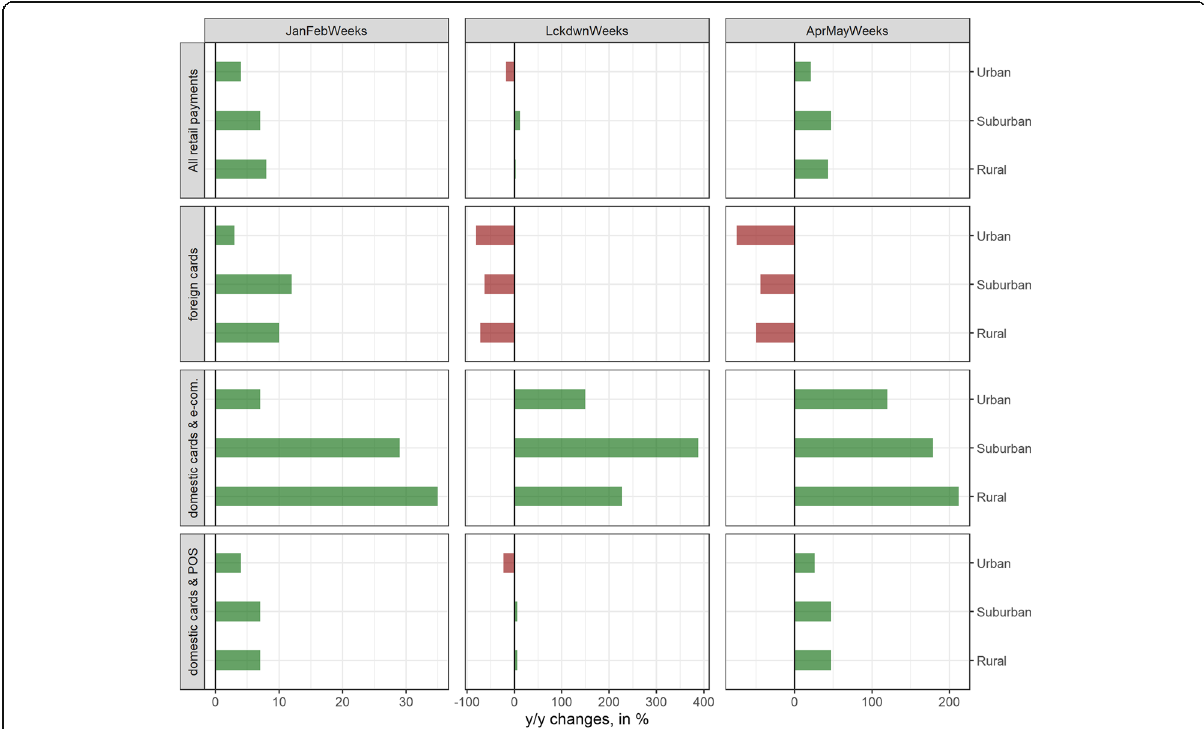
Fig. 8 Excess retail card payments (percentages) differentiated according to all payments (first panel), foreign-issued card payments (second panel), domestic card-not-present payments (third panel), and domestic card-present payments (fourth panel), and differentiated by urban, suburban, and rural areas (sub-panels) for the pre-lockdown (left), lockdown (middle), and post-lockdown (right) periods. Source: Own calculations,